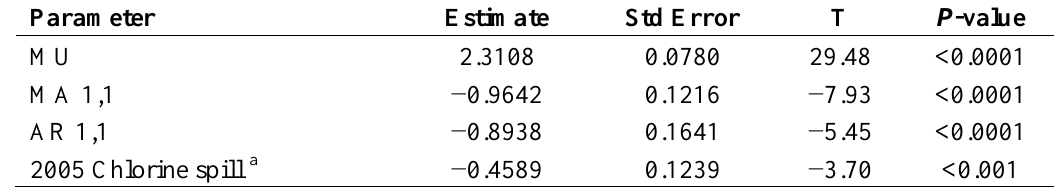
Table 2. ARMA (1,1) model parameter characteristics for Direct Group: SC Medicaid Beneficiaries,